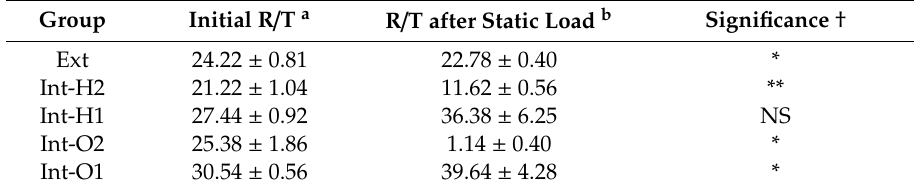
Table 5. Comparison of the mean values of initial and post-loading removal torque in each group. Group Initial R / T a